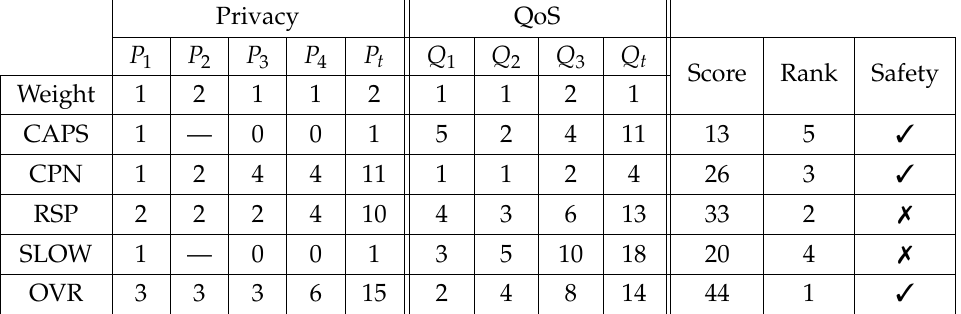
Table 6. Schemes comparison in the highway